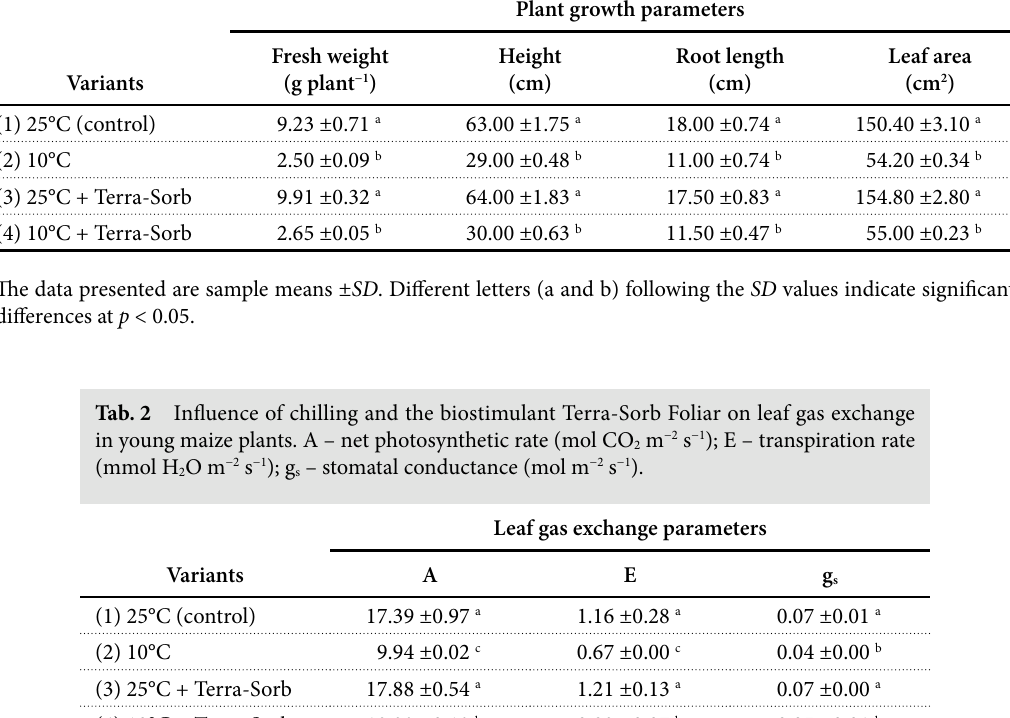
Tab. 1 Influence of chilling and the biostimulant Terra-Sorb Foliar on growth parameters of young maize plants.